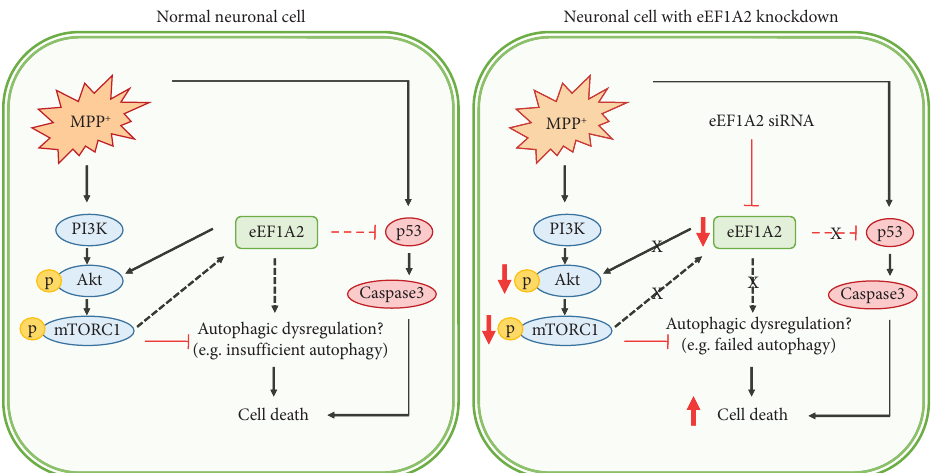
Figure 6: Conceptualized diagram of the efect of eEF1A2 knockdown on the Akt/mTOR pathway in MPP + -treated SH-SY5Y neuronal